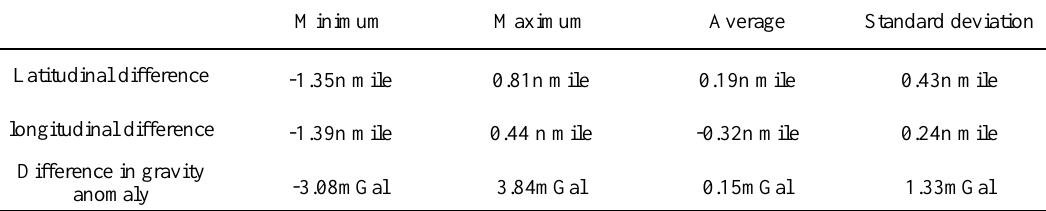
(c) Figure 3 . Matching results of track II Table 3 . The accuracy of matching navigation